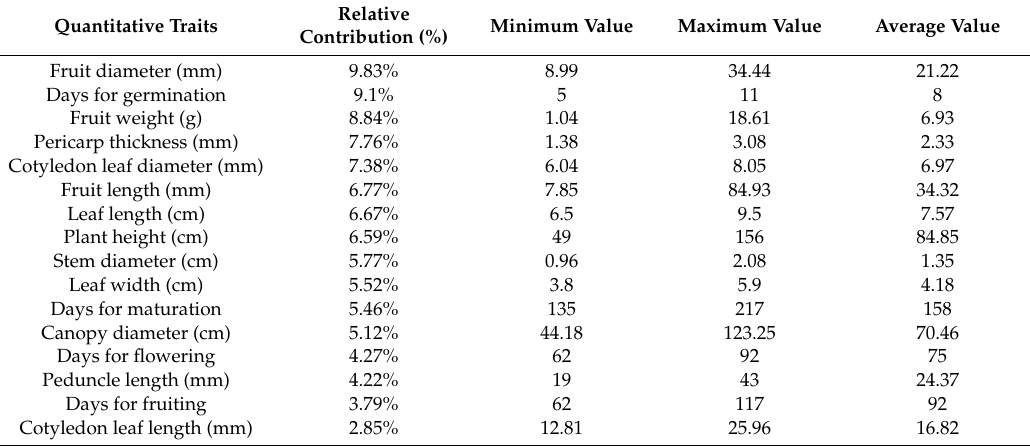
Table 1. Relative contribution of quantitative traits for C. chinense accessions genetic divergence. Quantitative